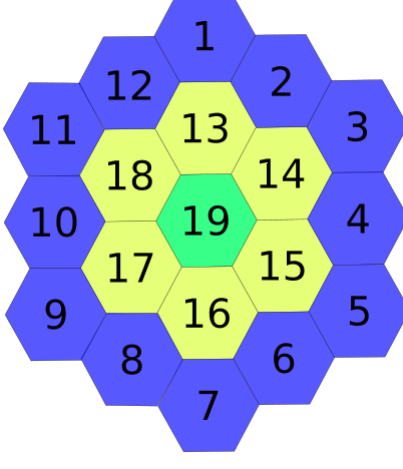
Figure 2. Environment as a